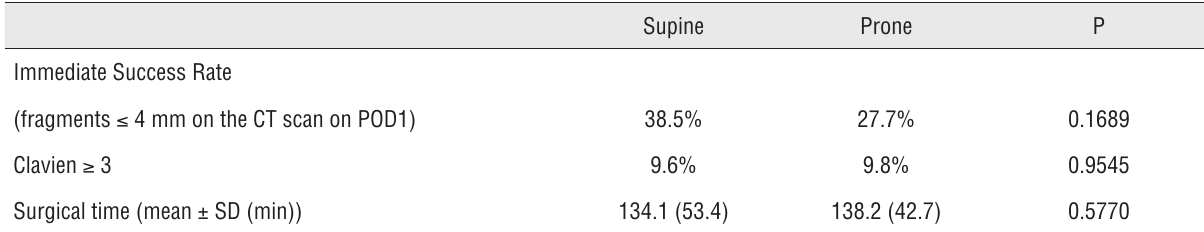
Table 2 - Outcomes of the pcNL for complex stones (Guy’s Stone Score 3 or 4) according to a prone or supine position. Supine